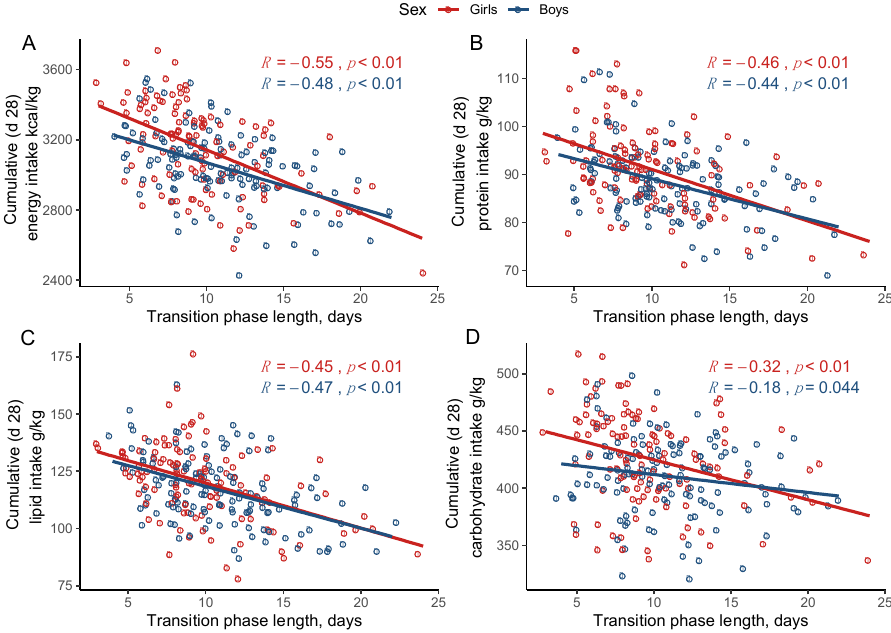
Figure 1. Correlations between transition phase length and cumulative energy ( A ), protein ( B ), lipid ( C ), and carbohydrate ( D ) intake at 28 days of age in girls and boys. Linear regression line is shown together with the 95% confidence interval (shaded). R corresponding to Pearson’s correlation coefficients.